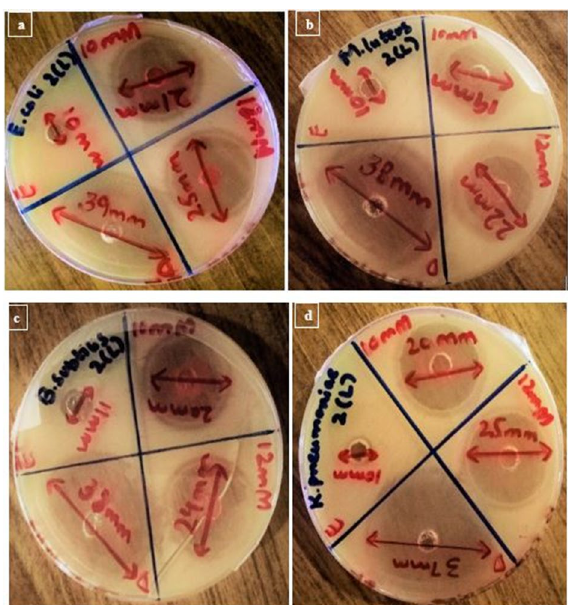
Figure 7. Antimicrobial activity analysis of SeNPs synthesized from Citrus limon (Lemon) fresh peels extract against bacterial pathogens; ( a ) E. coli , ( b ) M. luteus , ( c ) B. subtilis , ( d ) K. pneumoniae.